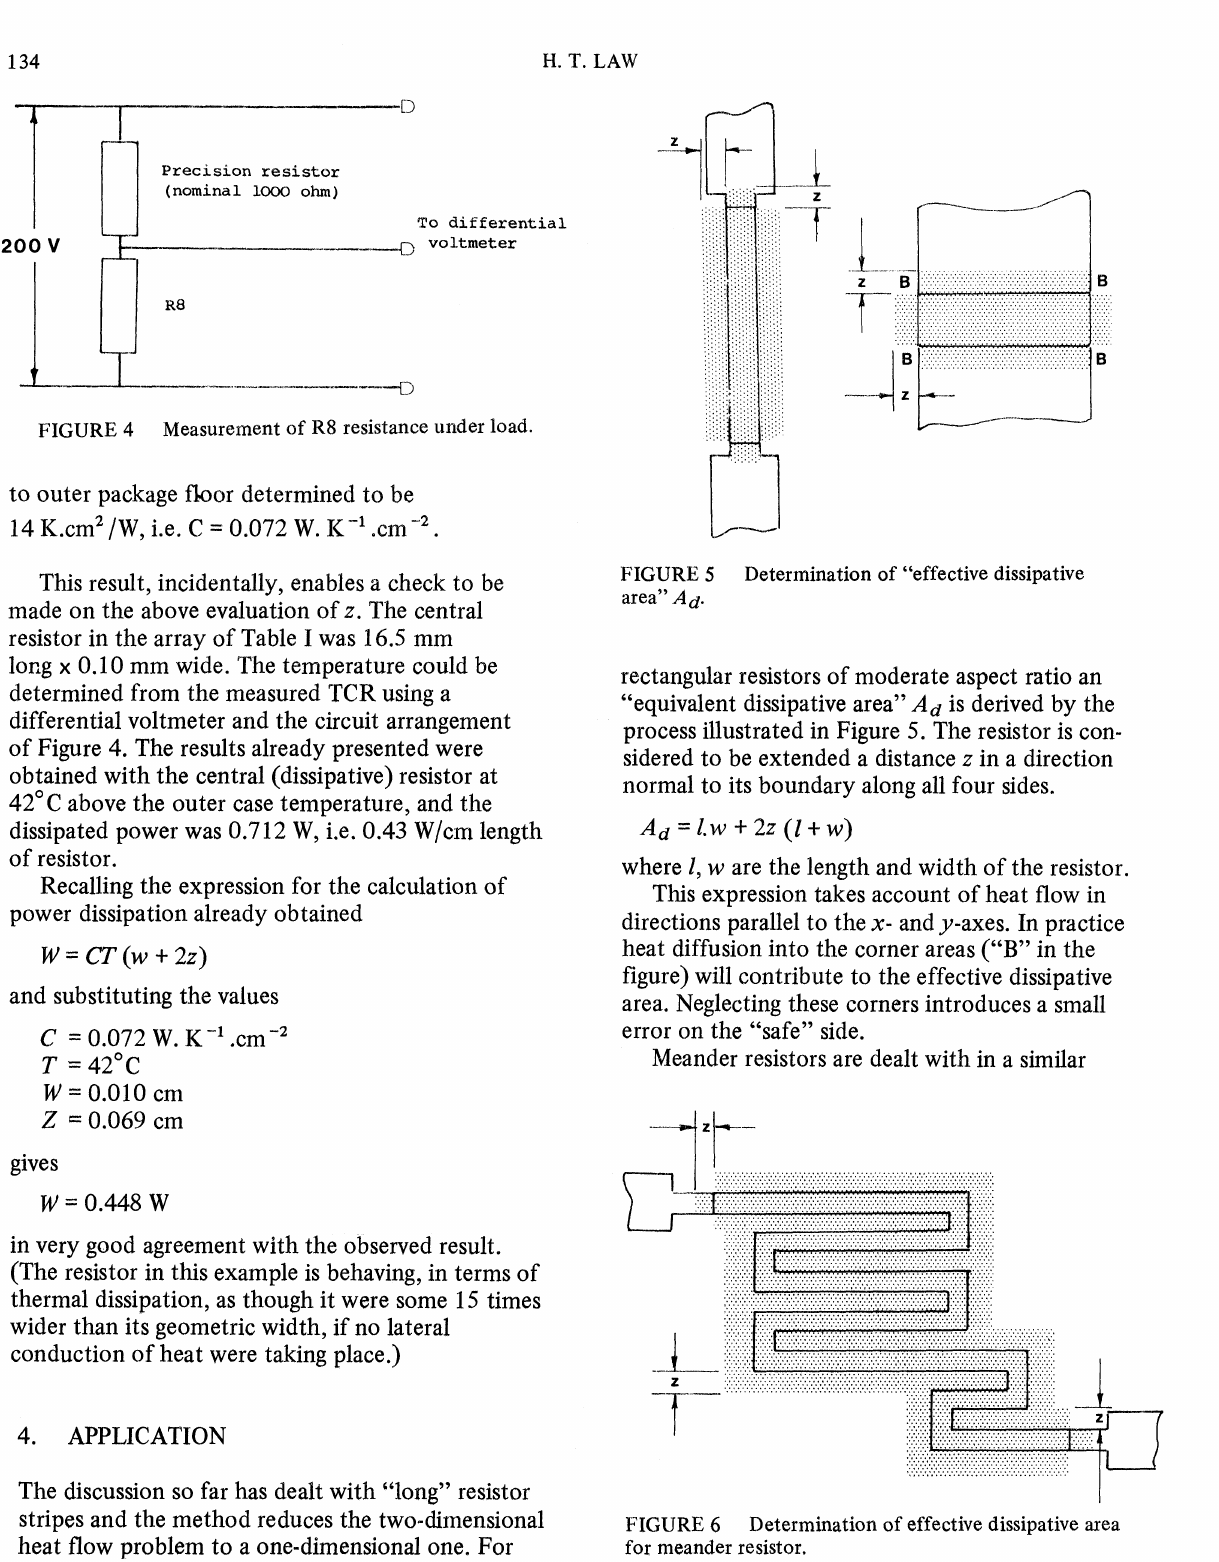
FIGURE 6 Determination of effective dissipative area for meander